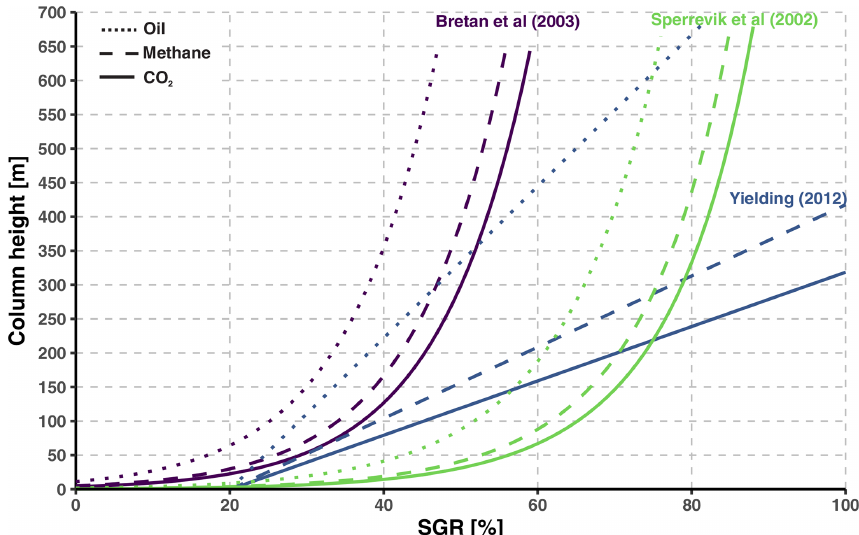
Figure 3. Plot of SGR content of fault rocks and the resulting column heights for the algorithms of Bretan et al. (2003), Sperrevik et al. (2002), and Yielding (2012) for different fluid types for a reservoir at a depth of 1000m. Assumes contact angles of 50 ◦ for CO 2 and 0 ◦ for methane and oil, with interfacial tensions of 38mNm − 1 for the CO 2 –brine–rock system, 60mNm − 1 for the methane–brine–rock system, and 30mNm − 1 for the oil–brine–rock system. Fluid densities are 515kgm − 3 for CO 2 , 75kgm − 3 for methane, 800kgm − 3 for oil, and 1035kgm − 3 for brine.